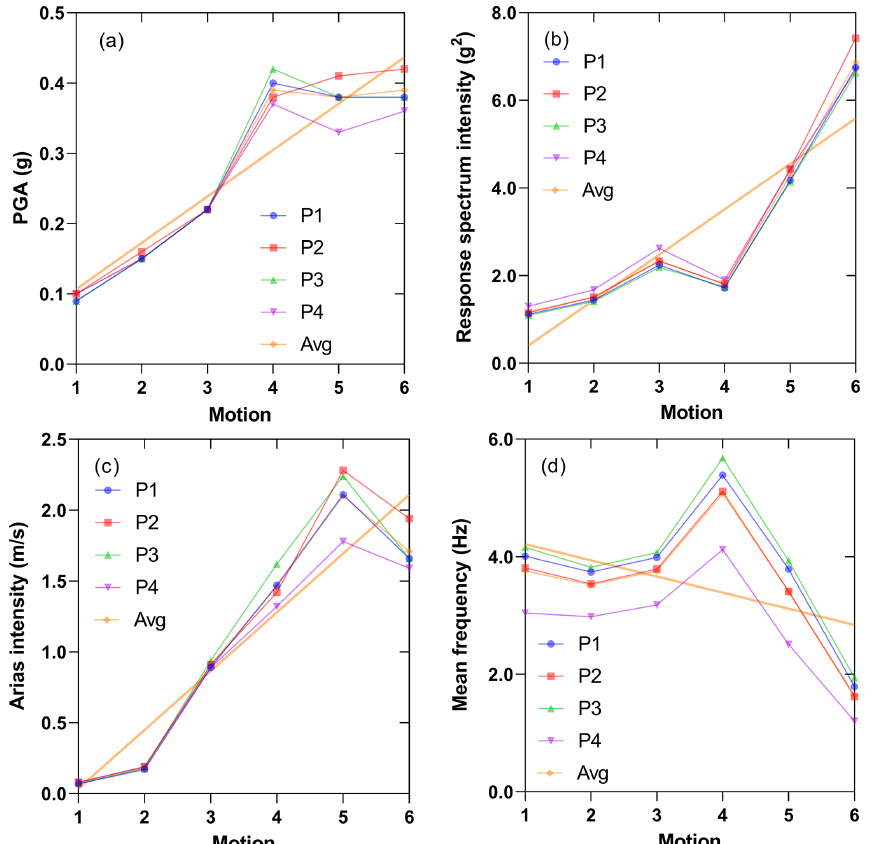
Figure 16. Sensitivity of input ground motion in Zone I. (a) Peak ground acceleration, (b) response spectrum intensity, (c) Arias intensity, and (d) mean frequency. Soil profiles: P1: Toorsa II; P2: Toorsa 1; P3: Dhamdhara II; and P4: Dhamdhara